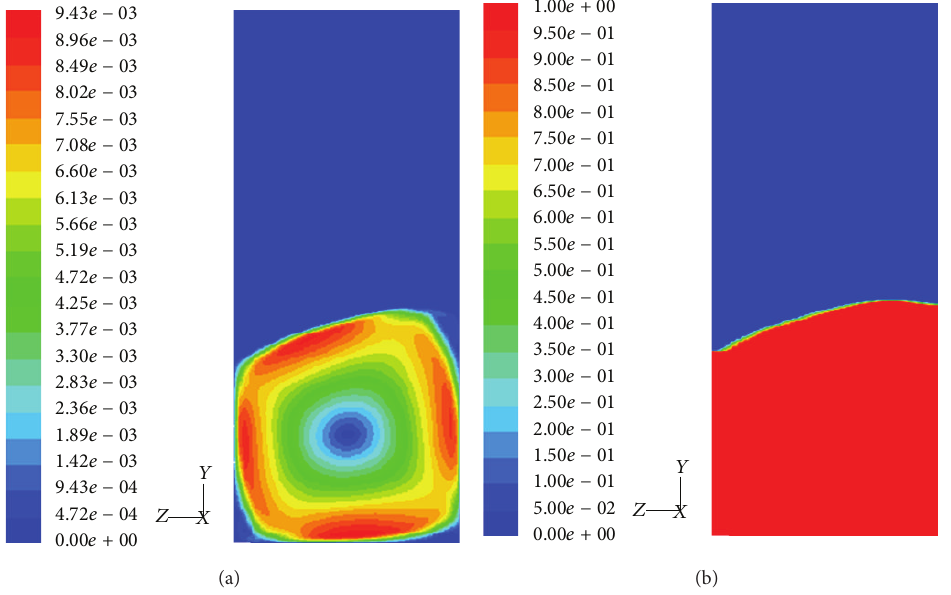
Figure 7: CFD simulation velocity (a) and liquid fraction (b) contours at 22min.